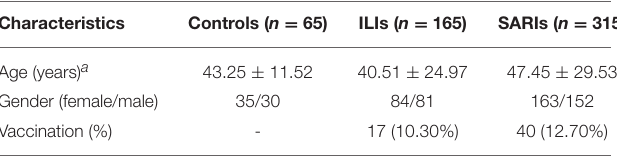
TABLE 1 | Clinical characteristics of study